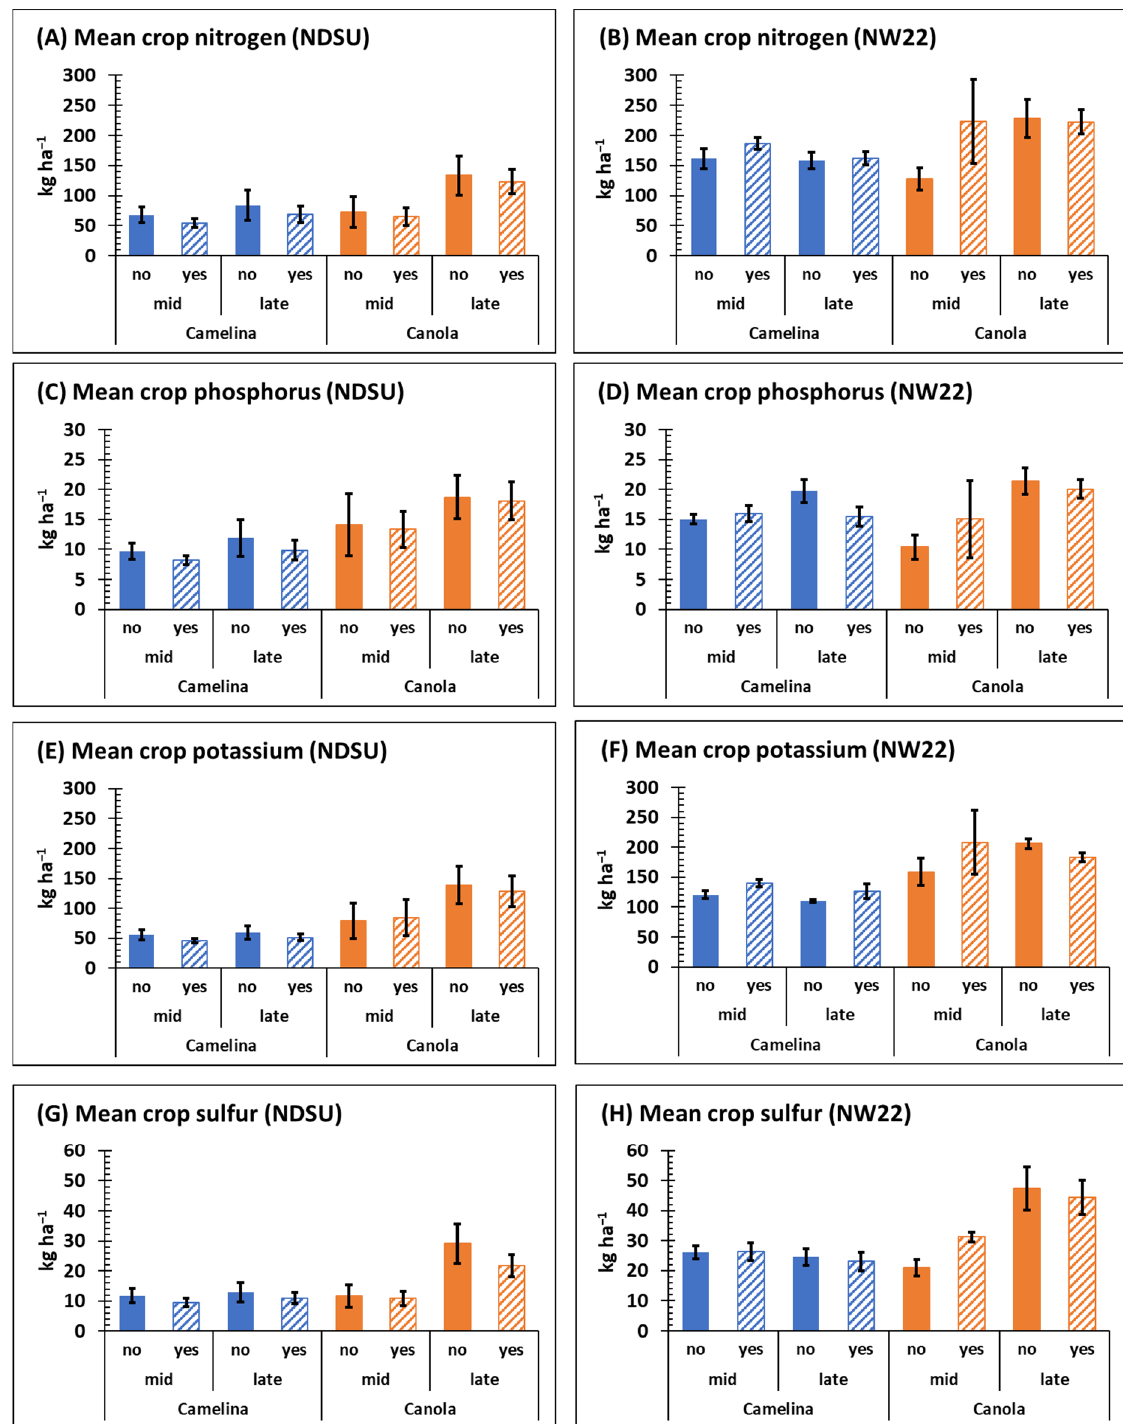
Figure 5. Mean nutrient content of sulfonylurea-resistant camelina and canola mid- and late-season at NDSU and NW22 treated with (yes) or without (no) sulfonylurea; nitrogen ( A , B ), phosphorus ( C , D ), potassium ( E , F ), sulfur ( G , H ). Error bars represent the standard error of the mean.